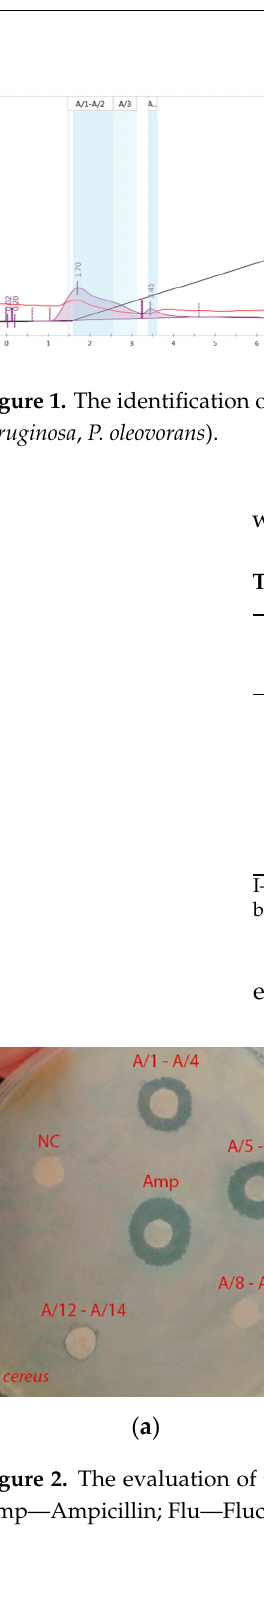
Table 4. The evaluation of the antimicrobial properties of isolated fractions.